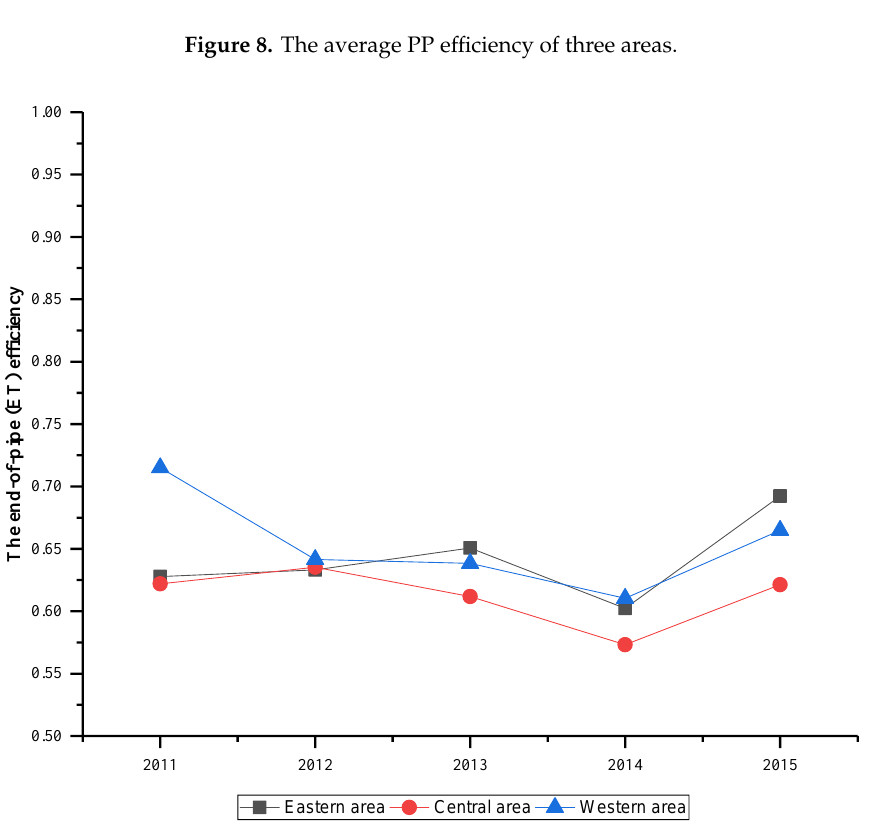
Figure 9. The average ET efficiency of three areas.